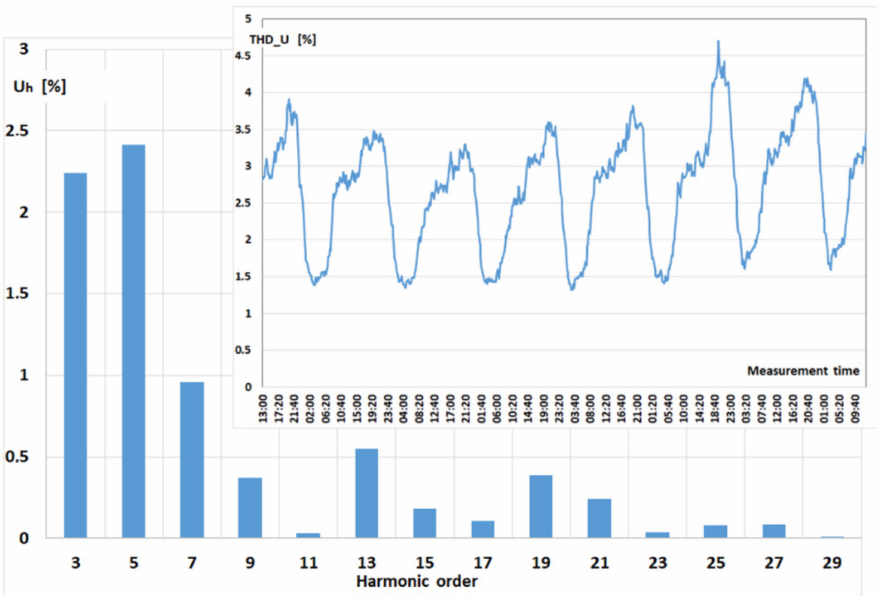
Figure 16. Spectrum of voltage harmonics and THD changes in line of a municipal consumer.